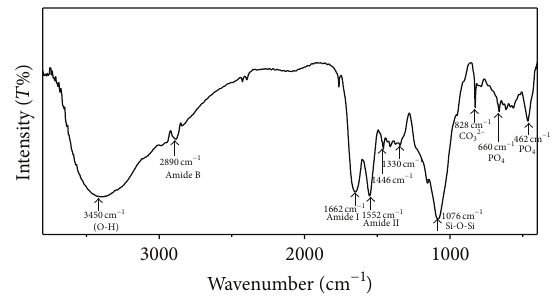
Figure 6: FTIR spectra of gelatin/chitosan/bioglass (GCB 10) com- posite scaffold.